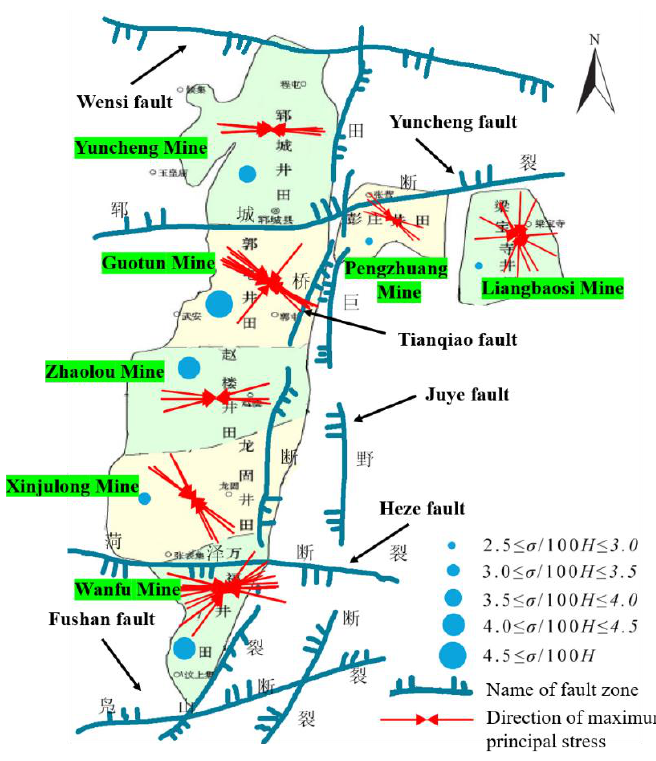
Figure 9. Directional distribution of the maximum horizontal principal stress.